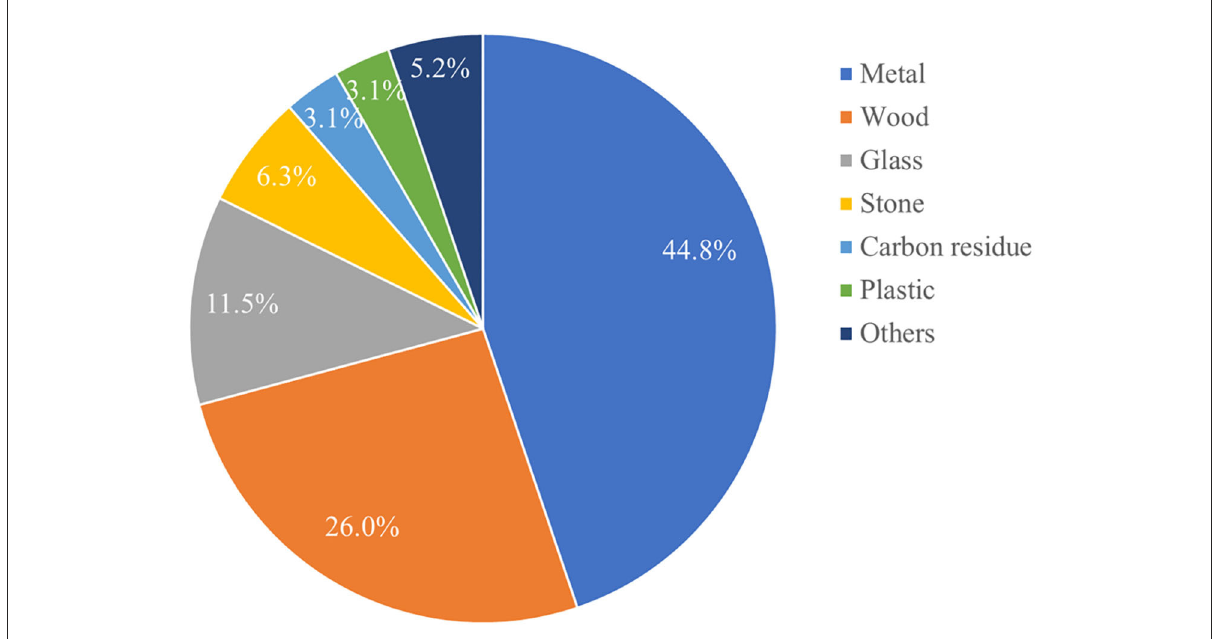
FIGURE1 The materials of foreign bodies (in